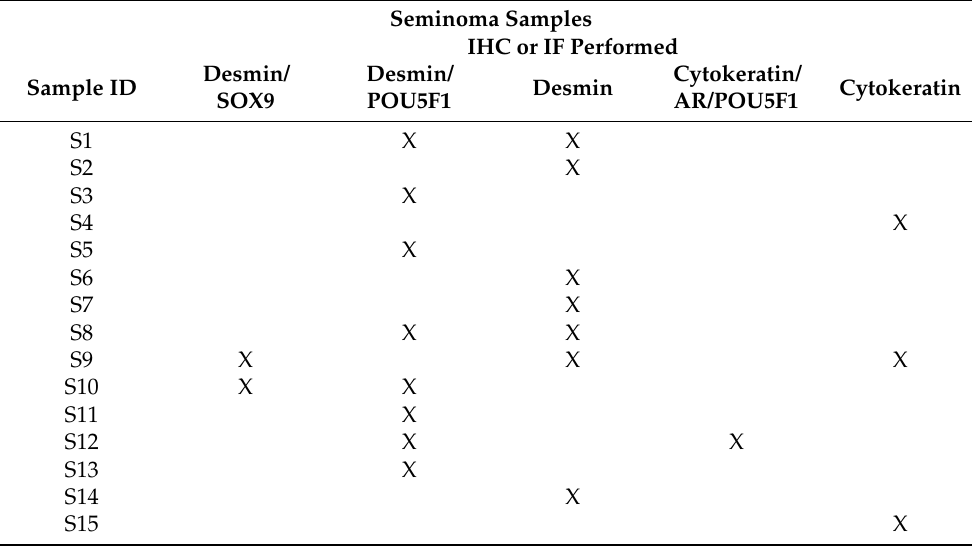
Table A4. Immunohistochemistry and Immunofluorescence performed on non-seminoma samples.